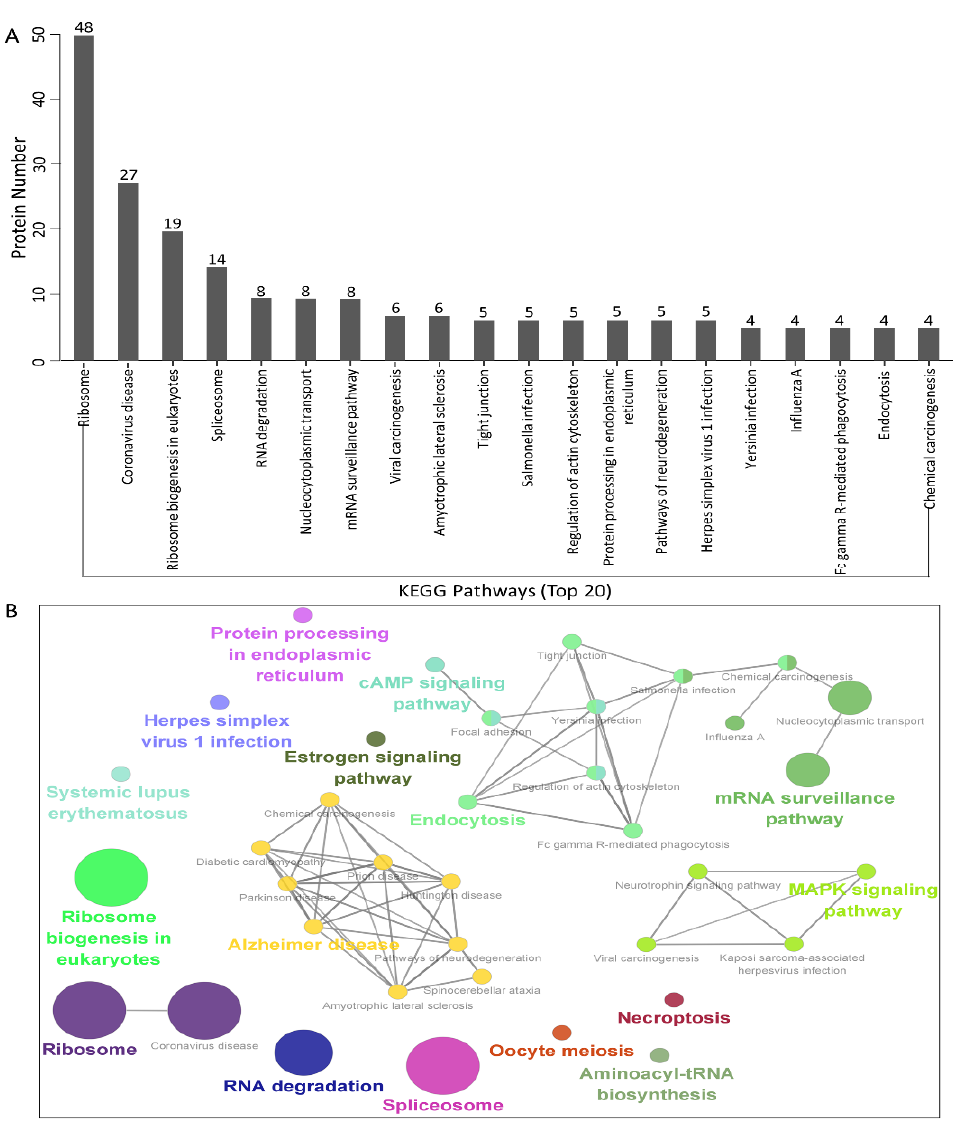
Figure 4. KEGG pathway enrichment analysis. ( A , B ) Graphs showing the enriched pathways tar- geted by the PEDV N protein-interacting proteins, as analyzed via KEGG functional annotation (Supplementary Table S4) using the GOclue plugin in Cytoscape software, version